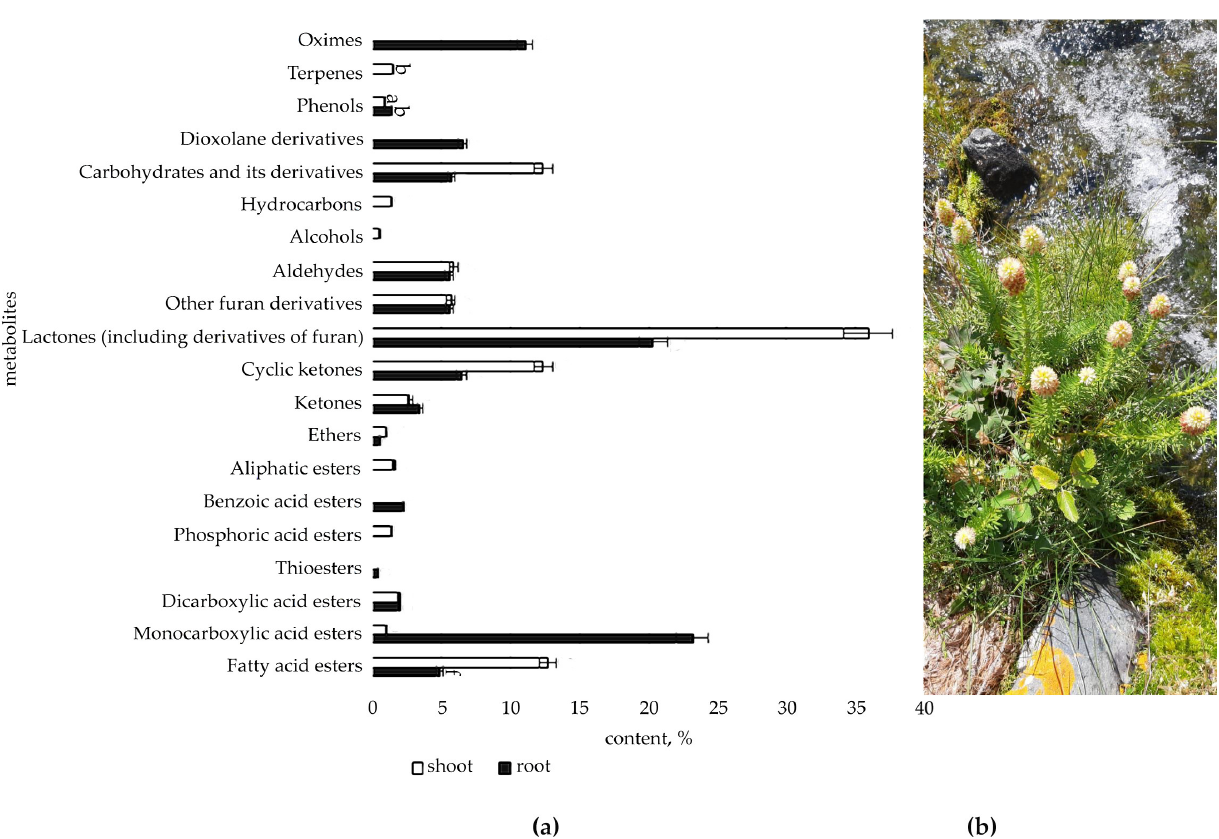
Figure 1. ( a ) Content of secondary metabolites classes of immature plants R. semenovii , %. Values presented are means (± SD). Different letters above the bars represent significant differences at p ≤